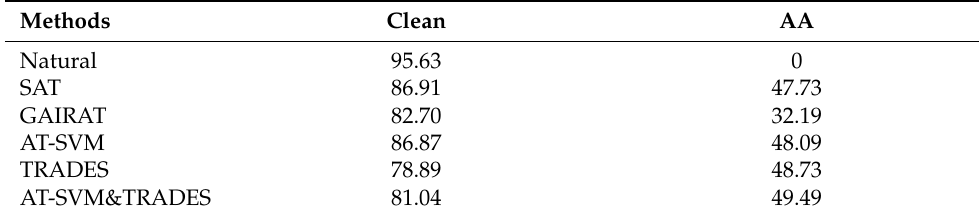
Table 6. AutoAttack’s test accuracy of ResNet-18 on the CIFAR-10